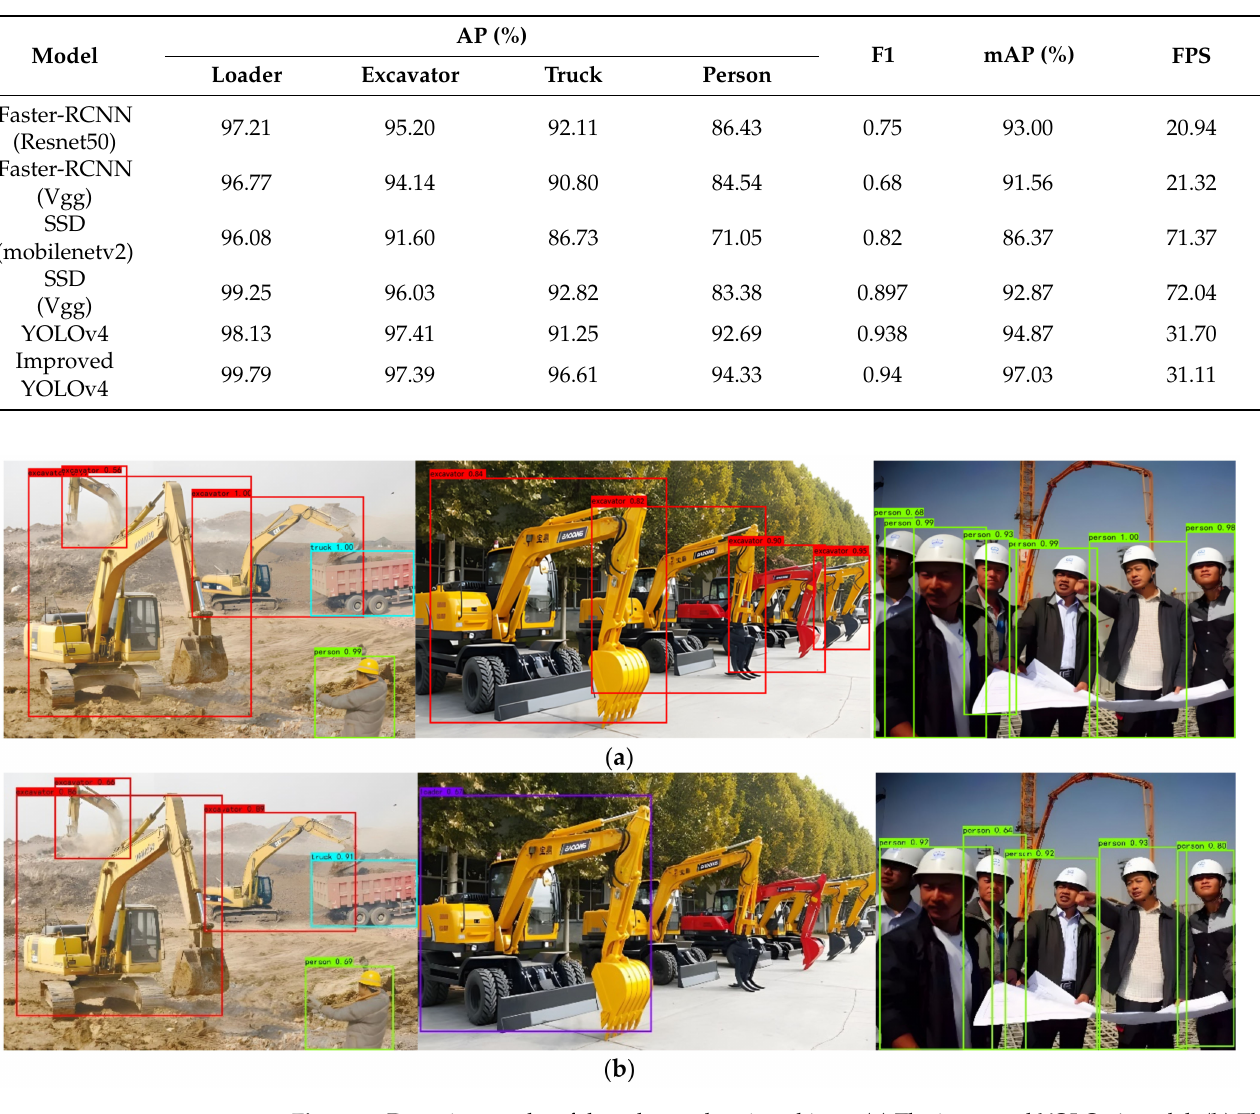
Figure 8. Detection results of densely overlapping objects. ( a ) The improved YOLOv4 model. ( b ) The Original YOLOv4